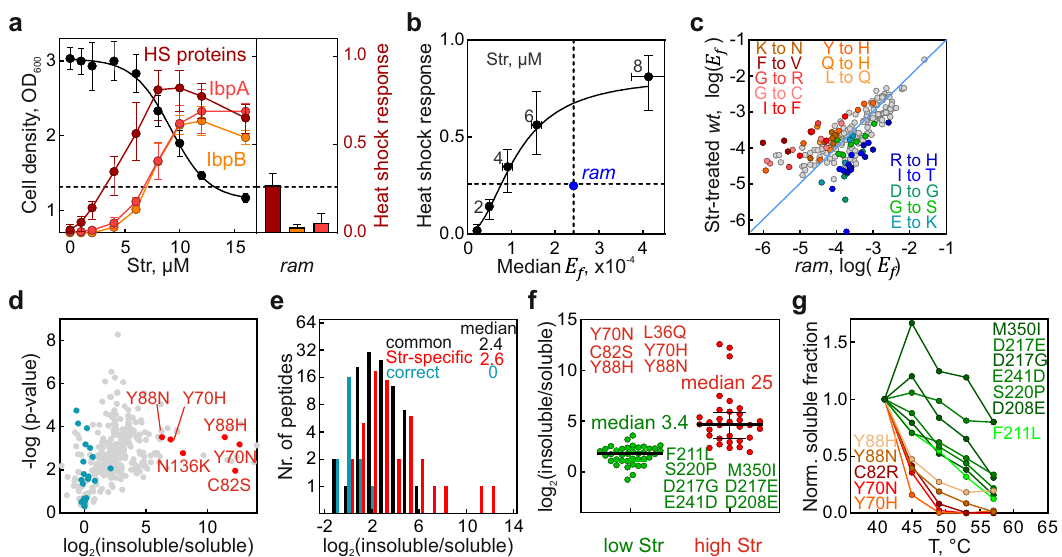
Fig. 1 Fitness, stress response, and miscoding of Str-treated wt and non-treated error-prone ram cells. a Str-induced growth inhibition and heat-shock (HS) response with E. coli wt cells (left panel) and analysis of the HS response in error-prone ram cells without AGA (right panel). Cell density at OD 600 (left Y-axis; shown are means ± standard deviation (SD) of three biological replicates ( n = 3)). Proteome changes were quanti fi ed by label-free quanti fi cation (LFQ). Co-regulated proteins were identi fi ed by hierarchical clustering (Supplementary Fig. 1a – e). LFQ values were normalized to interval (right Y-axis). IbpA and IbpB were also plotted individually to show their delayed induction. Shown are medians ± interquartile ranges of three biological replicates ( n = 3). The dashed line indicates the Str concentration at which the heat shock response is similar to ram cells. b Correlation between misreading and proteotoxic stress response for Str-treated wt cells (black) and untreated ram cells (blue). Error frequencies are means ± SEM of the medians of three biological replicates ( n = 3). HS are median ± interquartile ranges. c Misreading pro fi les of wt Str-treated and ram cells (6 µ M Str; Supplementary Fig. 1g), with Str-speci fi c amino acid substitutions shown in warm colors; amino acid substitutions speci fi c for ram strain are in cold colors. Shown are the means of three technical replicates ( n = 3). d Volcano plot visualizing enrichment of amino acid substitutions in aggregates. Distribution between insoluble/soluble fractions of substitutions (gray) was normalized by the median of the correct peptides (turquoise). Selected substitutions enriched in aggregates are highlighted red. Shown are means of three technical replicates ( n = 3). e Aggregation propensity of Str-speci fi c amino acid substitutions. Categories of Str-speci fi c and common errors are derived from Supplementary Fig. 1g (8 µ M Str), data for the propensity to be enriched in aggregates from Fig. 1d. f Aggregation propensity of proteins with errors induced at low and high Str concentrations. Categories are from Supplementary Fig. 2a, data from Fig. 1d. Median ± interquartile ranges are shown. Unpaired, one-tailed t test: p value: 1.4 x 10 – 8 . g Effect of errors on in-vitro thermostability of EF-Tu. Shown are means of three technical replicates ( n = 3). See also Supplementary Figs. 1, 2, and Source data fi